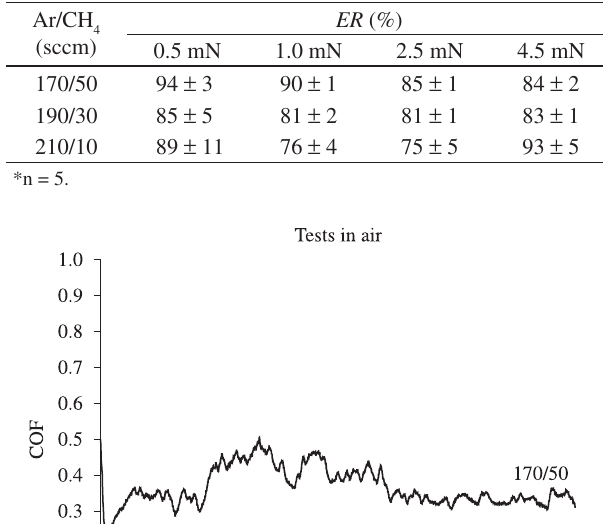
Table 2. Elastic recovery ( ER ) of produced carbon coatings obtained from scratch tests for different normal loads (mean value ± standard